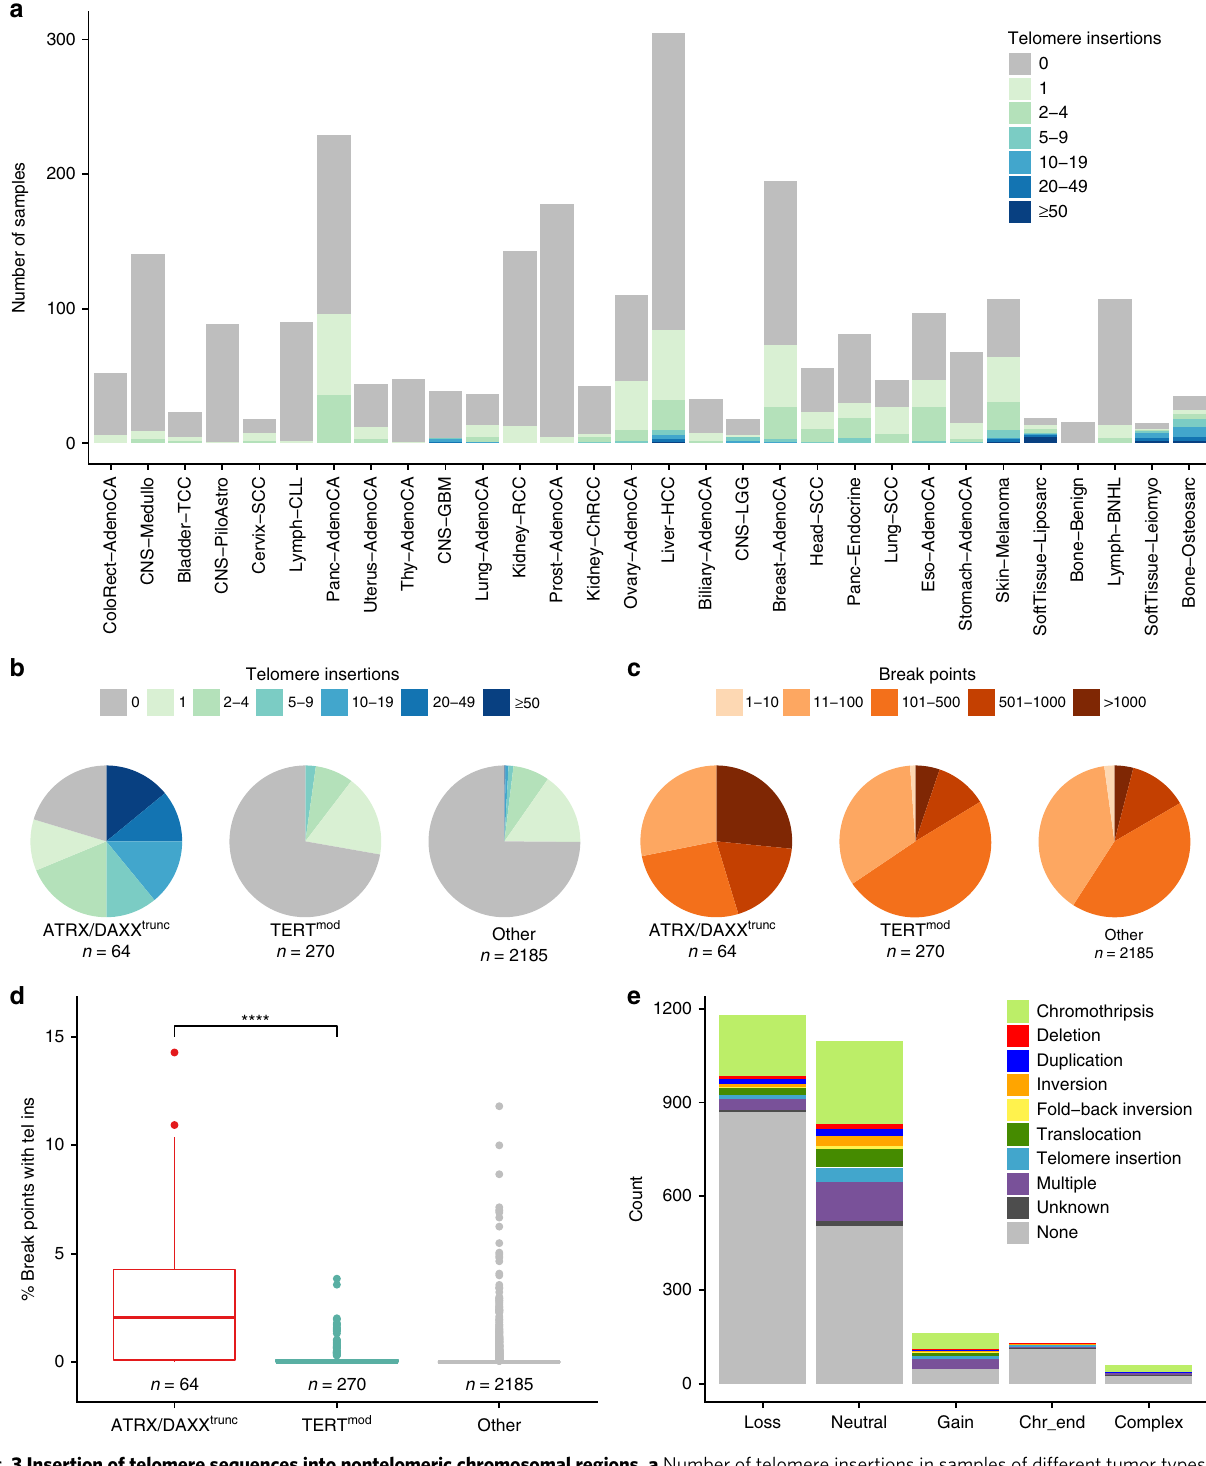
Fig. 3 Insertion of telomere sequences into nontelomeric chromosomal regions. a Number of telomere insertions in samples of different tumor types. The tumor types are sorted by mean telomere content tumor/control log2 ratios. Cohorts with sample sizes <15 are not shown. b Number of telomere insertions in samples with different TMM-associated mutations. c Number of breakpoints in samples with different TMM-associated mutations. d Percent of breakpoints coinciding with telomere insertions in samples with different TMM-associated mutations. The center line of the boxplot is the median, the bounds of the box represent the fi rst and third quartiles, the upper and lower whiskers extend from the hinge to the largest or smallest value, respectively, no further than 1.5 × IQR from the hinge (where IQR is the interquartile range, or distance between the fi rst and third quartiles). **** p < 0.0001, Wilcoxon rank-sum test. e Copy number changes of adjacent segments accompanying telomere insertions. “ Complex ” means that the copy numbers between segments differ in more than four copies. Overlaps with regions of chromothripsis are indicated. For telomere insertions that did not overlap with regions of chromothripsis, structural variations, or additional telomere insertions within 10 kb are